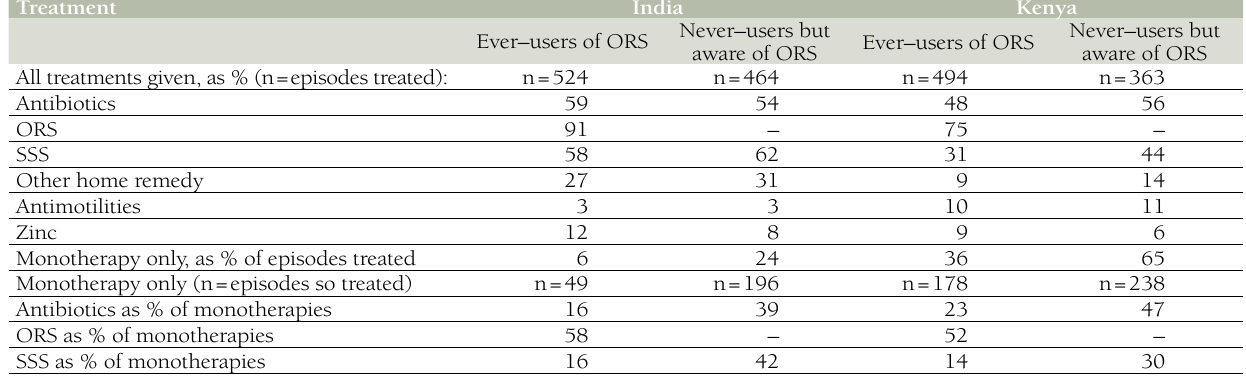
Table 5. Treatments given at last episode of diarrhea* Treatment